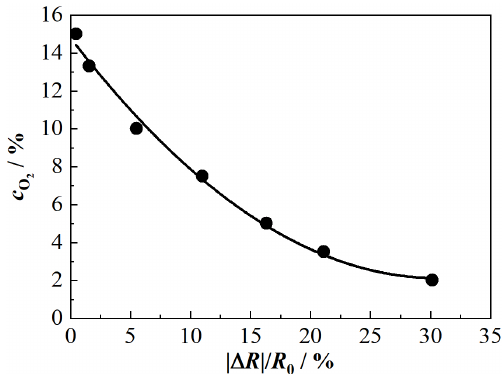
Figure 6. Characteristic curve of the O 2 -sensitive functional layer; sensor temperature: 650 ◦ C; O 2 variation balanced by N 2 : 2%,